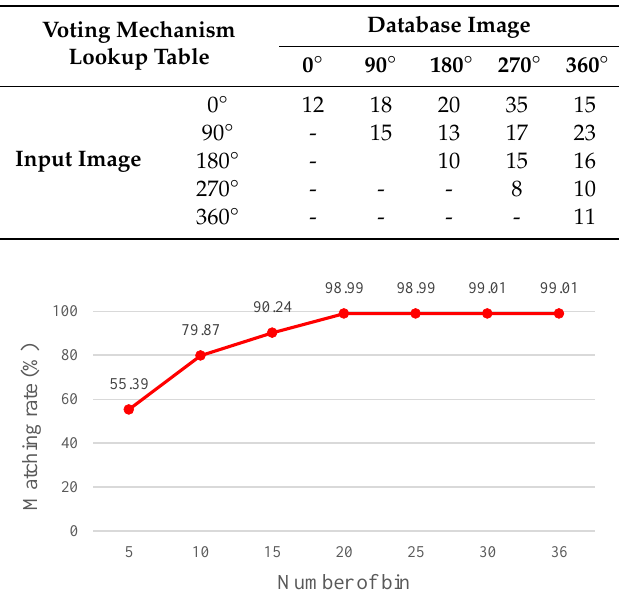
Figure 17. Matching rate achieved through various numbers of rotations.